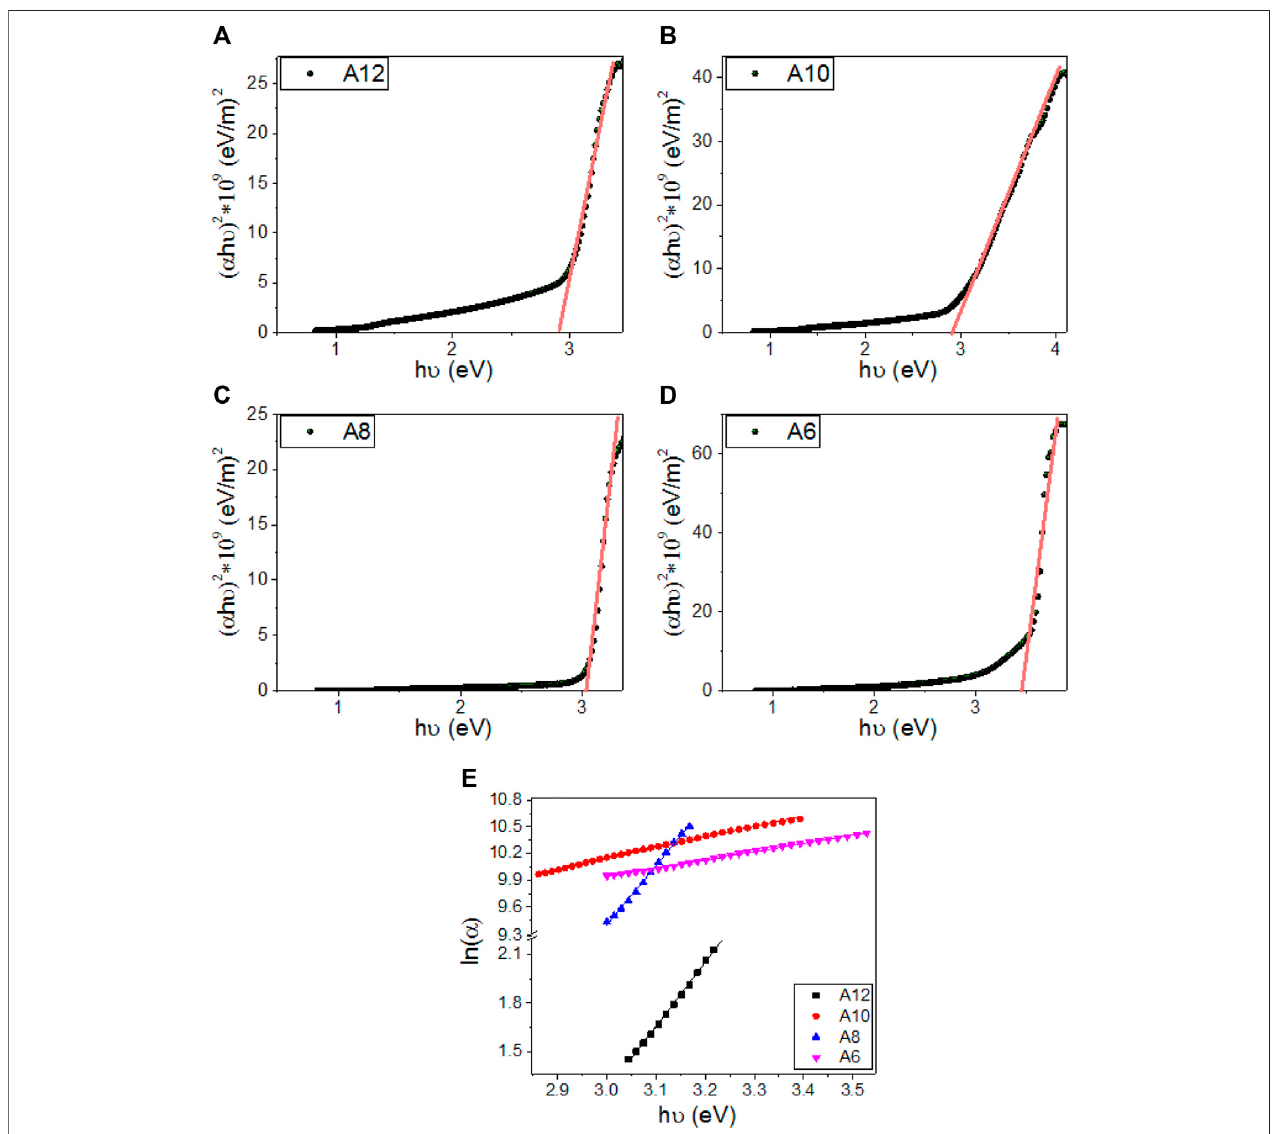
FIGURE 9 | Calculation of energy gap for (A) A12 , (B) A10 , (C) A8 , (D) A6 derivatives, and (E) calculation of Urbach energy for An series.